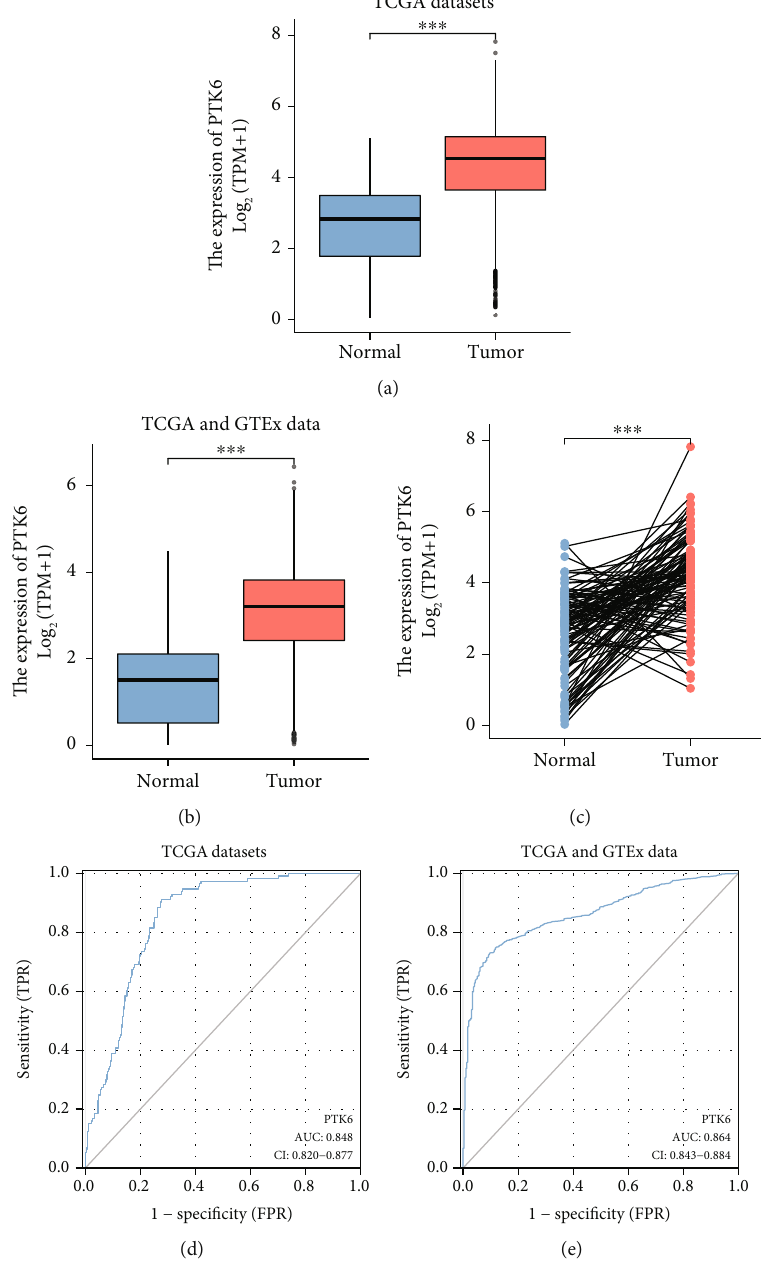
Figure 4: The expression and diagnostic value of PTK6 in BC patients. (a, b) PTK6 upregulation was con fi rmed in BC specimens compared with nontumor specimens in the TCGA datasets or the integrated GTEx database and TCGA database. (c) The results of unpaired t -test showing the overexpression of PTK6 in BC. (d, e) ROC curve of predictive value for BC specimens from the TCGA datasets or the integrated GTEx database and TCGA database. ∗ p < 0 : 05 , ∗∗ p < 0 : 01 , and ∗∗∗ p < 0 : 001